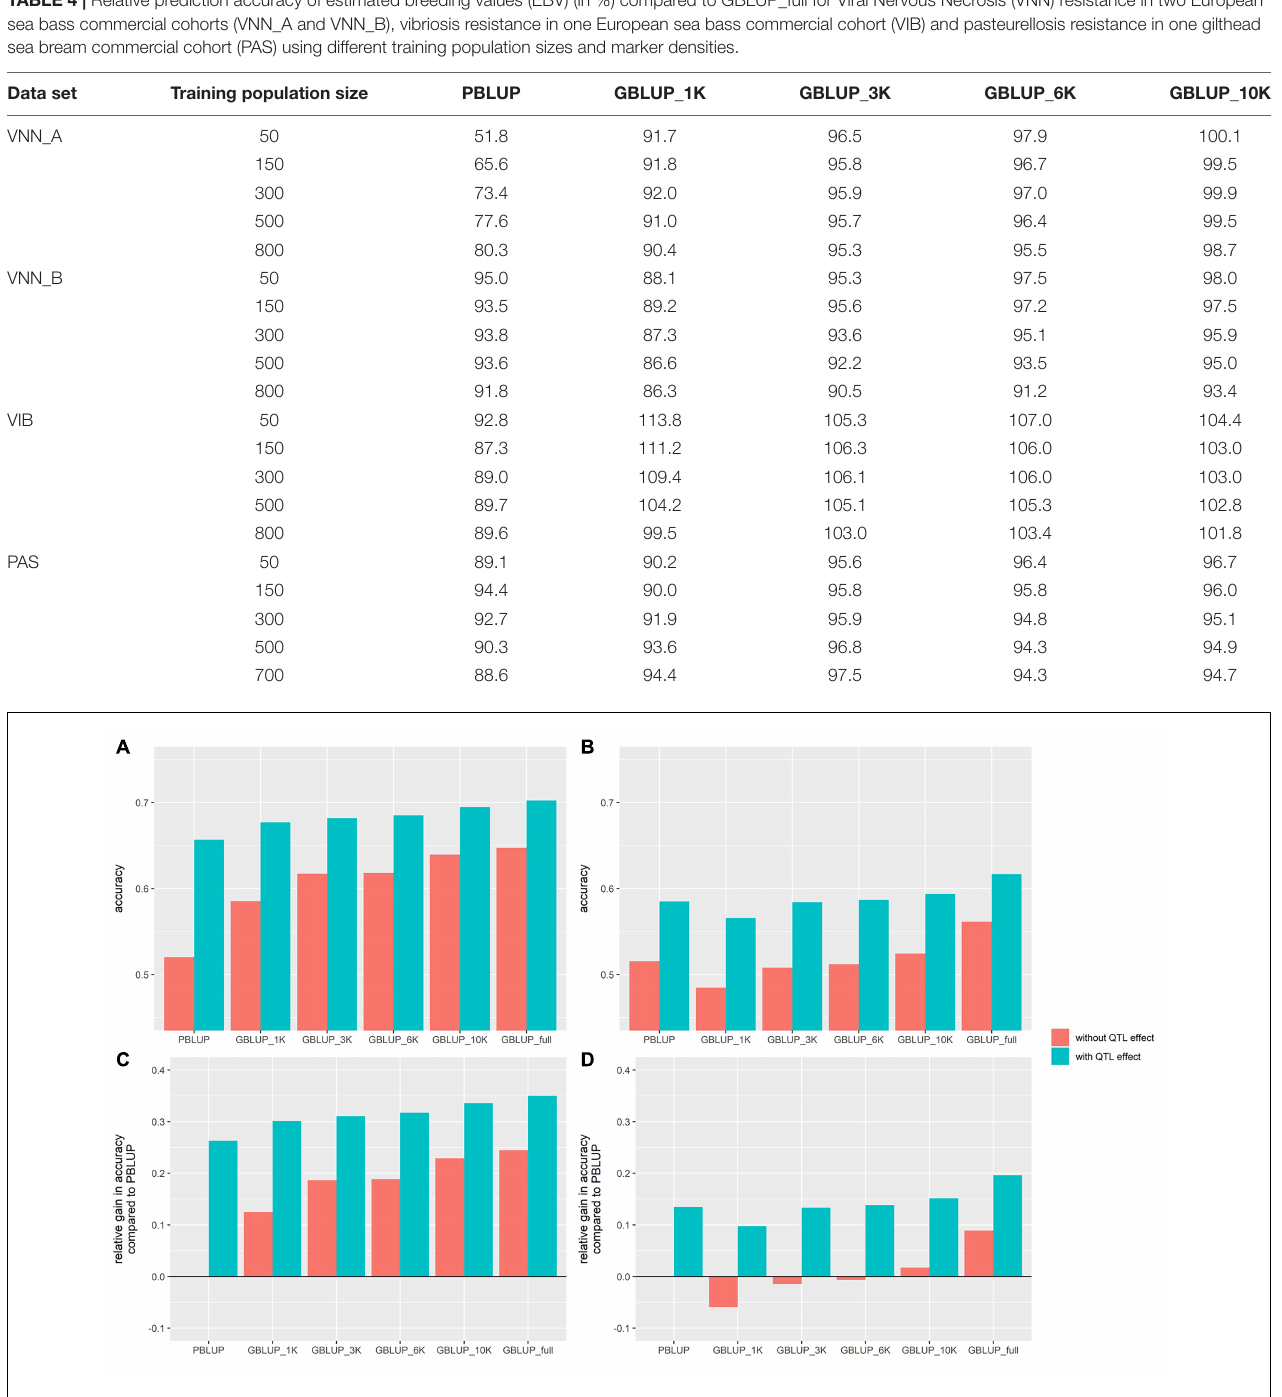
FIGURE 4 | Accuracy of genomic (GBLUP) and pedigree-based (PBLUP) estimated breeding values for VNN resistance in two European seabass commercial cohorts (VNN_A, A and VNN_B, B ) with different SNP chip densitiesand with (in blue) or without (in red) the QTL effect and a training population of 800 individuals. Relative gain in accuracy compared to the GBLUP_full model ignoring the QTL effect in cohort VNN_A (C) and VNN_B (D) .